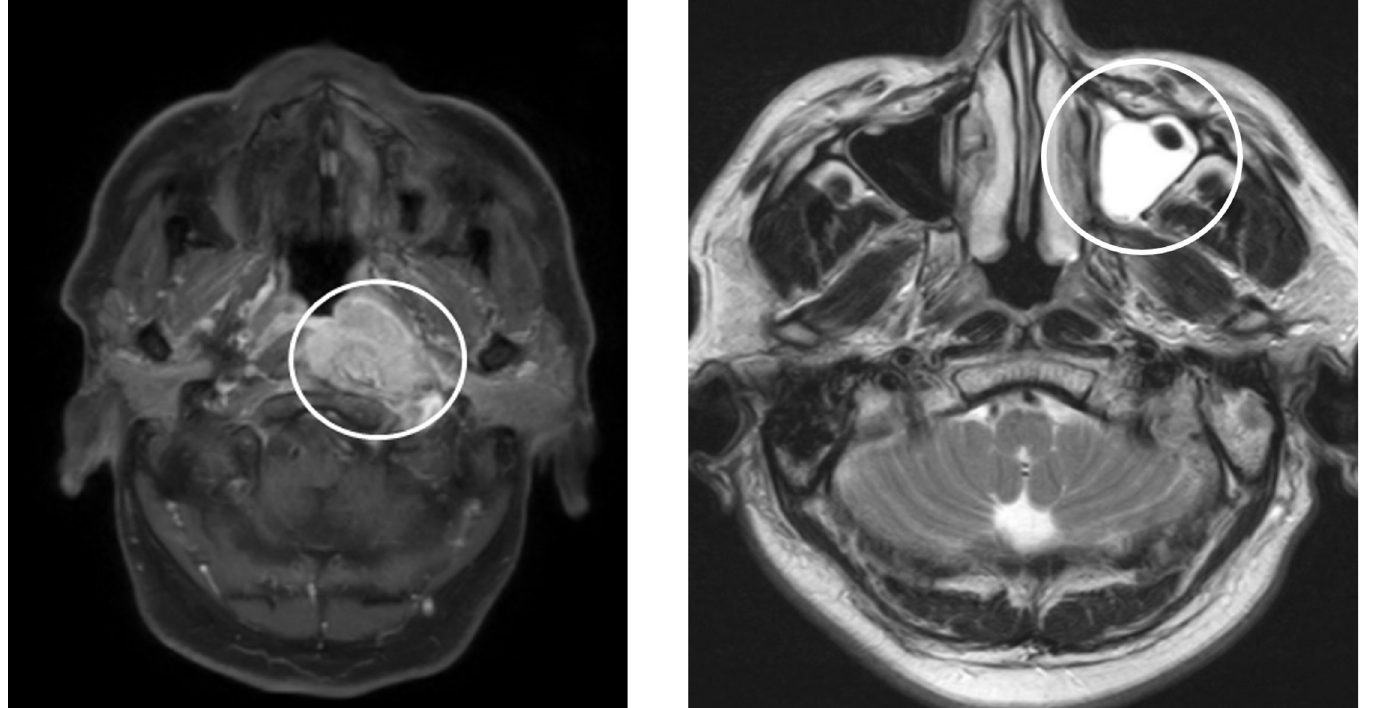
Fig 1. The MRI images. (a) a Stage II NPC patient (b) a CRS patient.